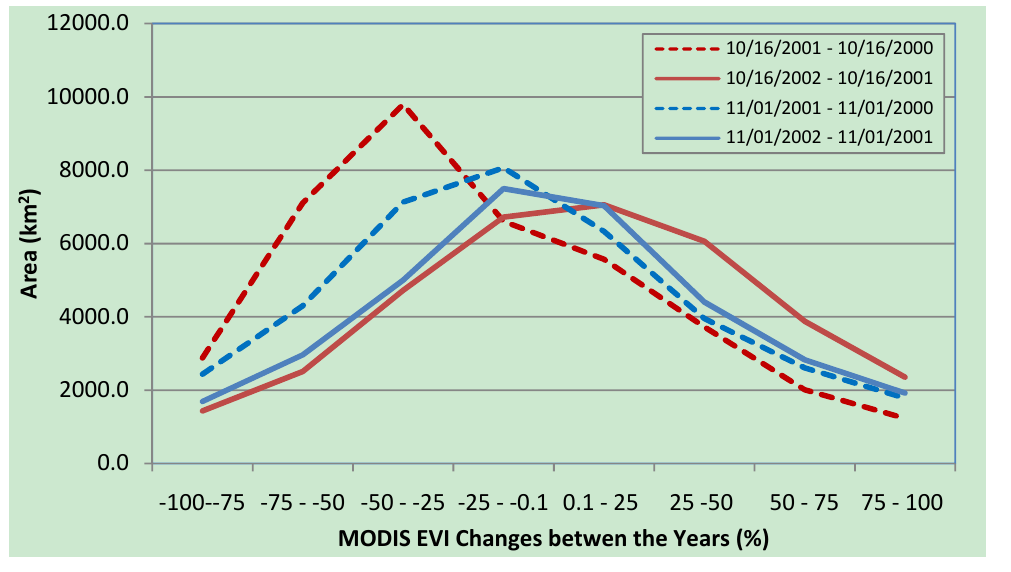
Figure 12. Area of vegetation in the coastal zone by category of MODIS EVI changes between the